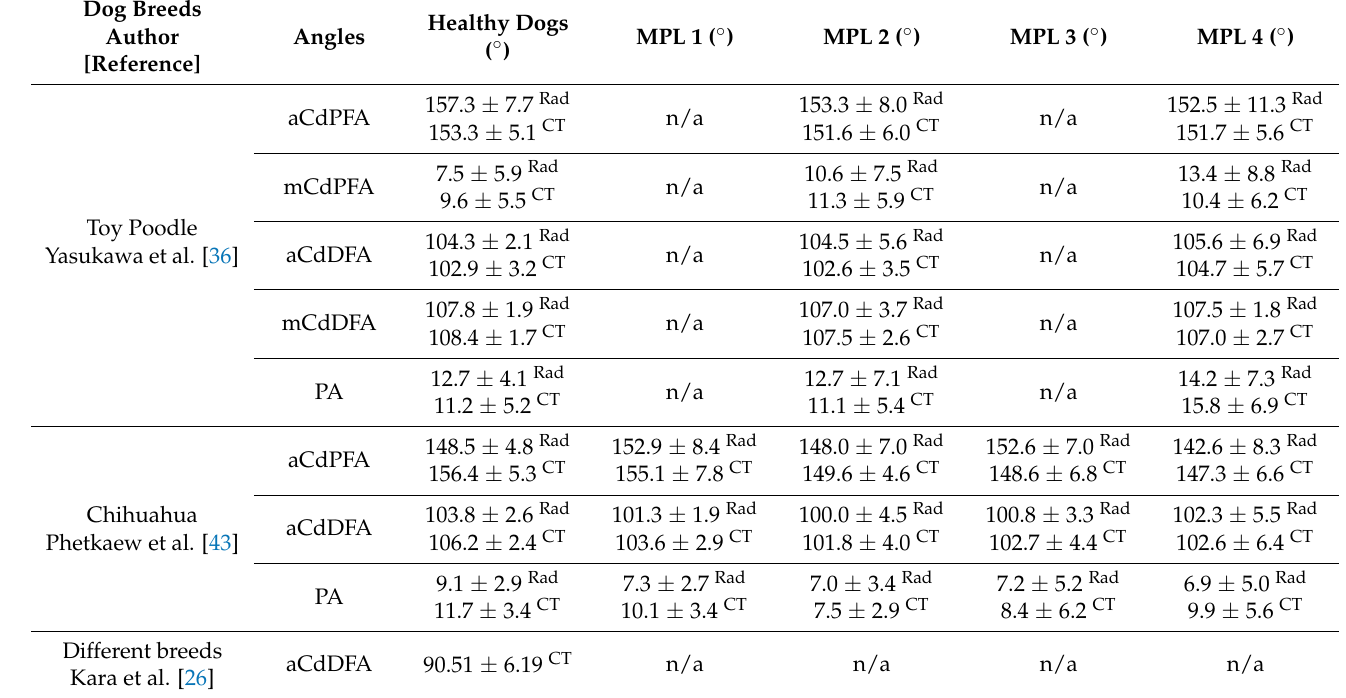
Table 11. Mean ± standard deviation of the anatomical caudal proximal femoral angle, mechanical caudal proximal femoral angle, anatomical caudal distal femoral angle, mechanical caudal distal femoral angle, and procurvatum angle, as recorded in the included